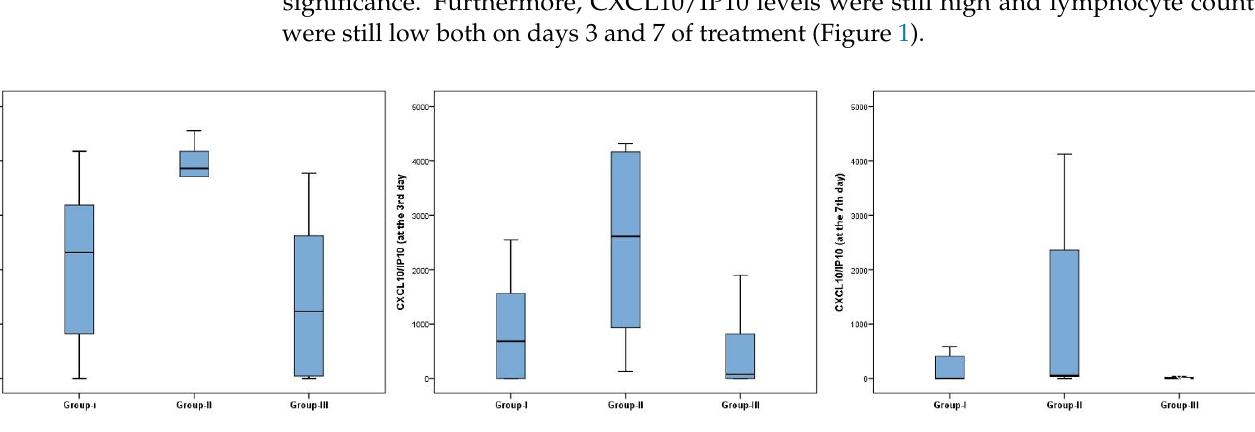
Figure 1. CXCL10/IP10 levels according to subgroups.